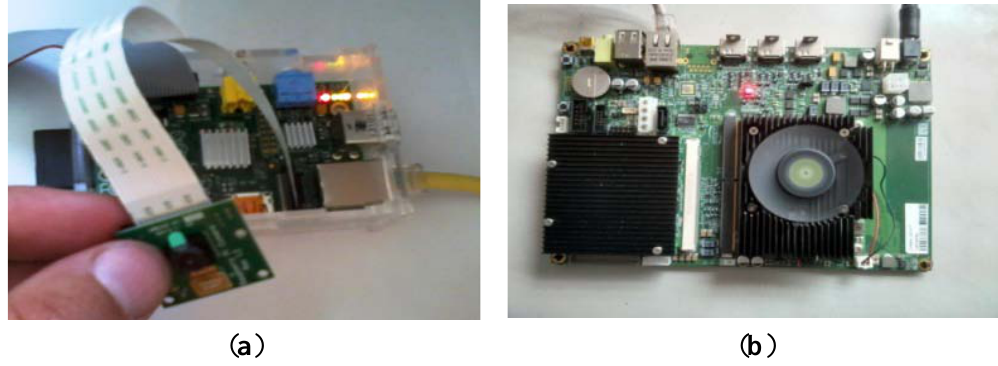
Figure 18. Scheme of the low-cost system. ( a ) Raspberry Pi and ( b ) A